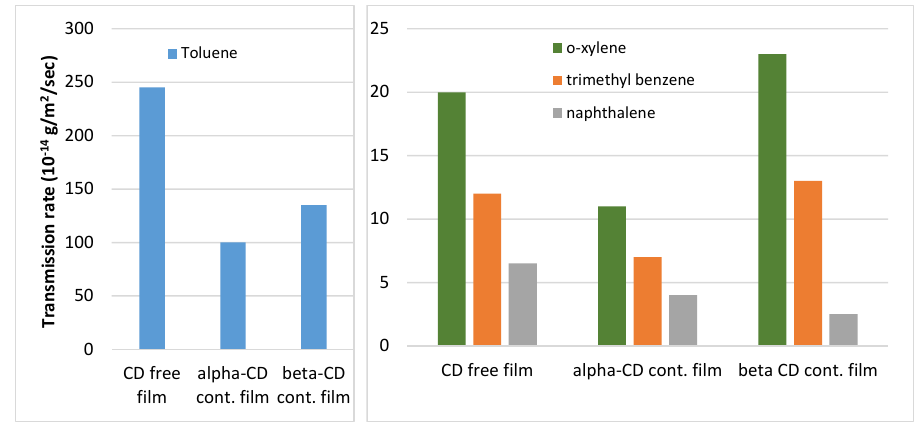
Figure 4. Transmission rate of several aromatic hydrocarbons through a usual, and through 0.5% α‐ and β‐CD‐containing polyethylene films (based on data from [110]).